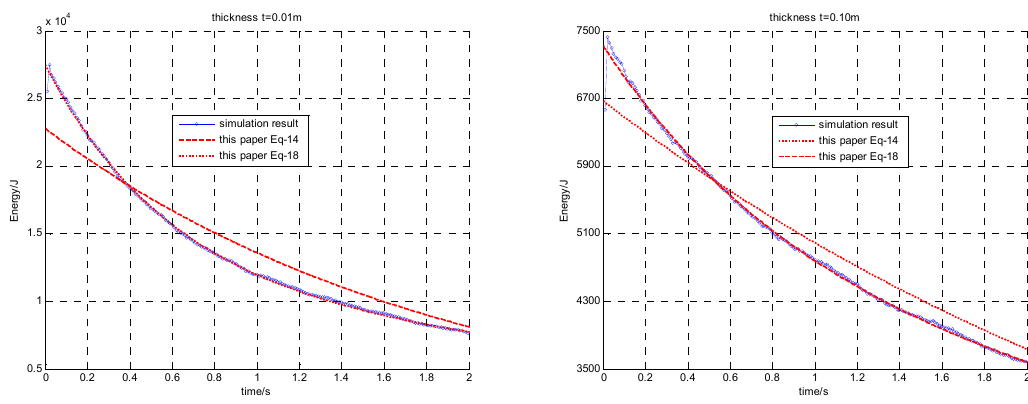
Figure 27. The comparison between Equations (14) and (18). Table 3. The initial total energy ( × 10 4 J) and the ratio β at di ff erent T / m.